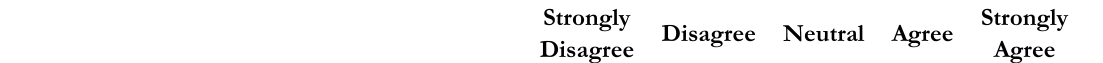
Table 7: DSG * Q9 Cross tabulation